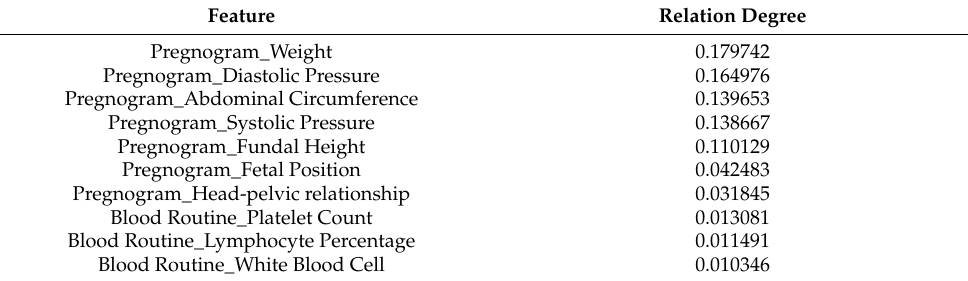
Table 2. Top 10 features of